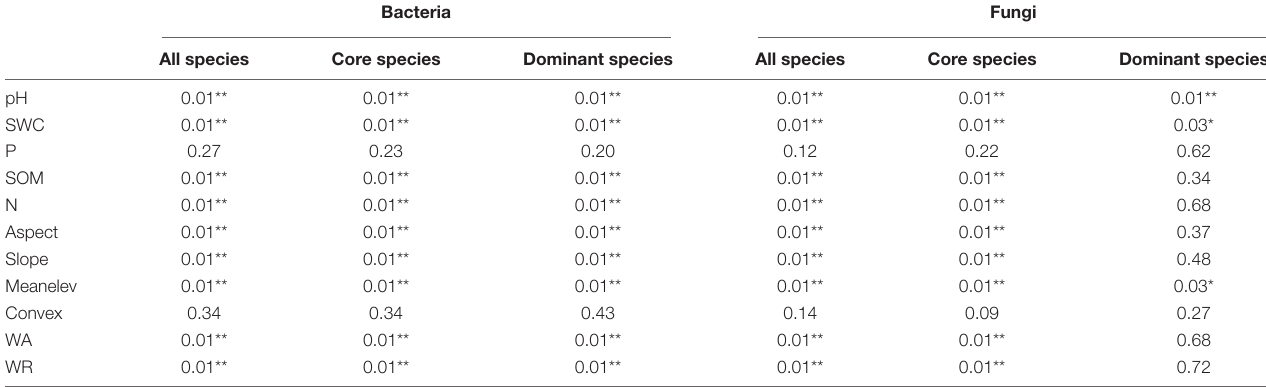
TABLE 1 | Redundancy analysis (RDA) of effects of different environmental factors on soil bacteria and fungi. Bacteria Fungi